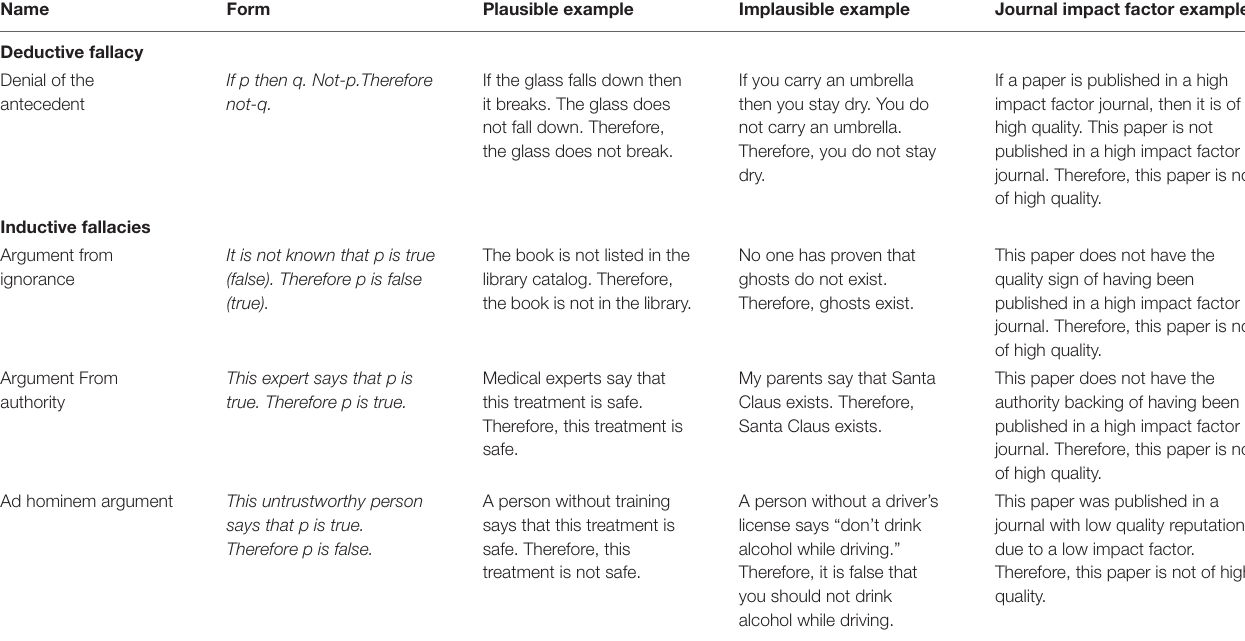
TABLE 1 | The deductive and inductive fallacies discussed in this